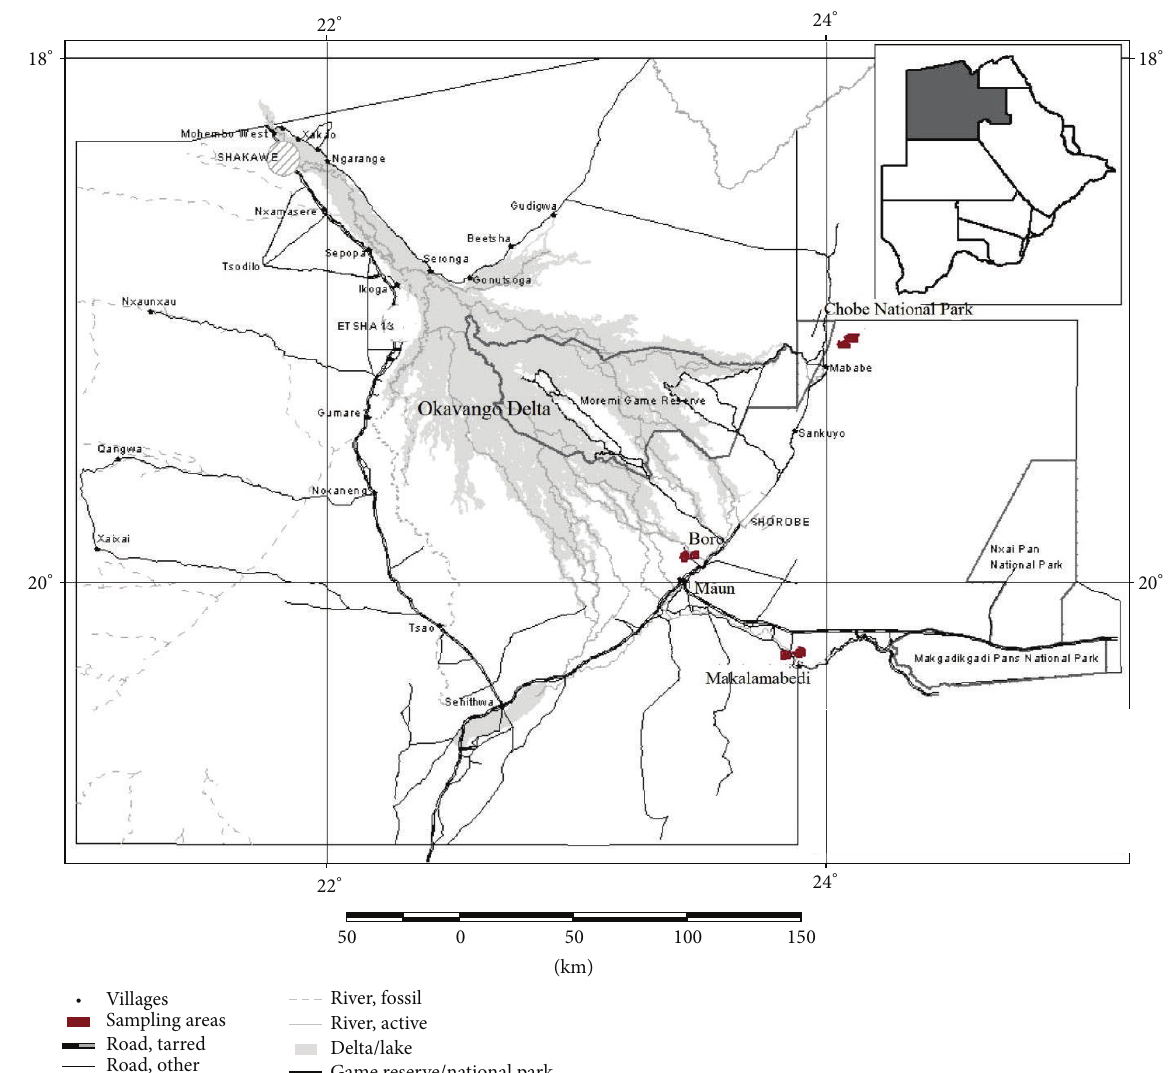
Figure 1: Map of Okavango Delta (Maun) and Kasane areas in Botswana showing the sampling sites.